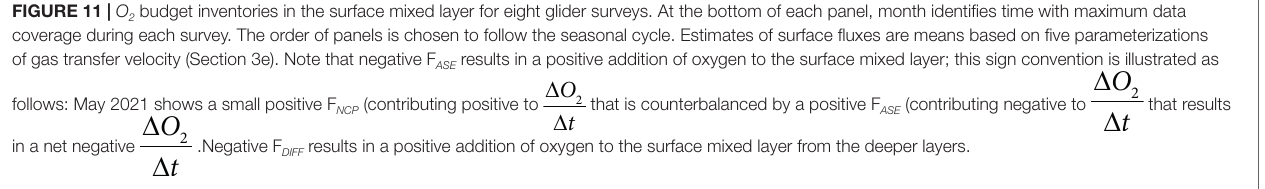
∆ O 2 that is counterbalanced by a positive F ASE (contributing negative to ∆ t